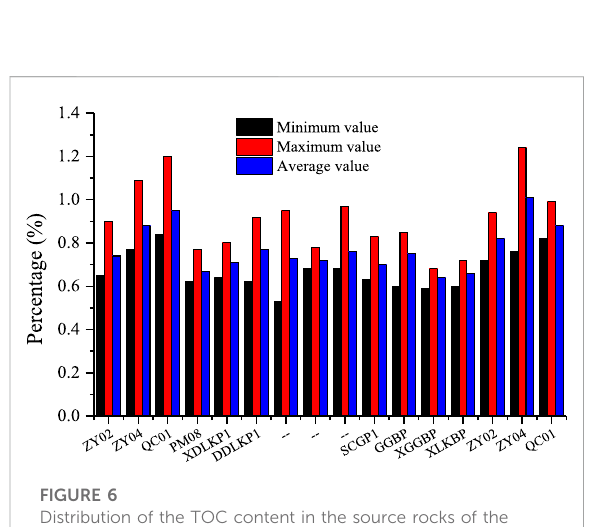
FIGURE 7 Percentage of clay minerals and components in the upper and middle – lower